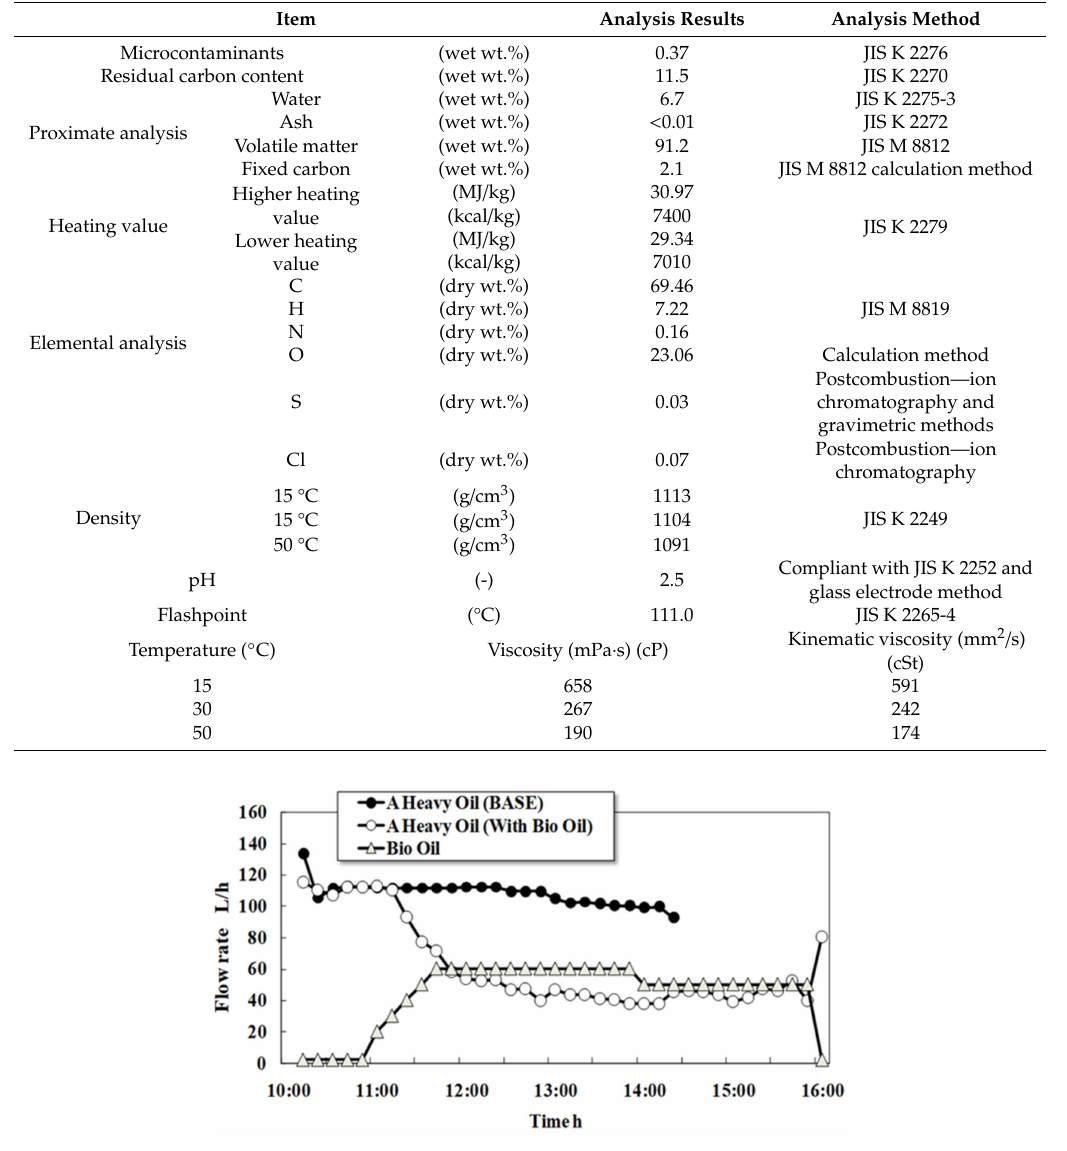
Figure 7. Results of bio-oil and A-fuel oil co-combustion test